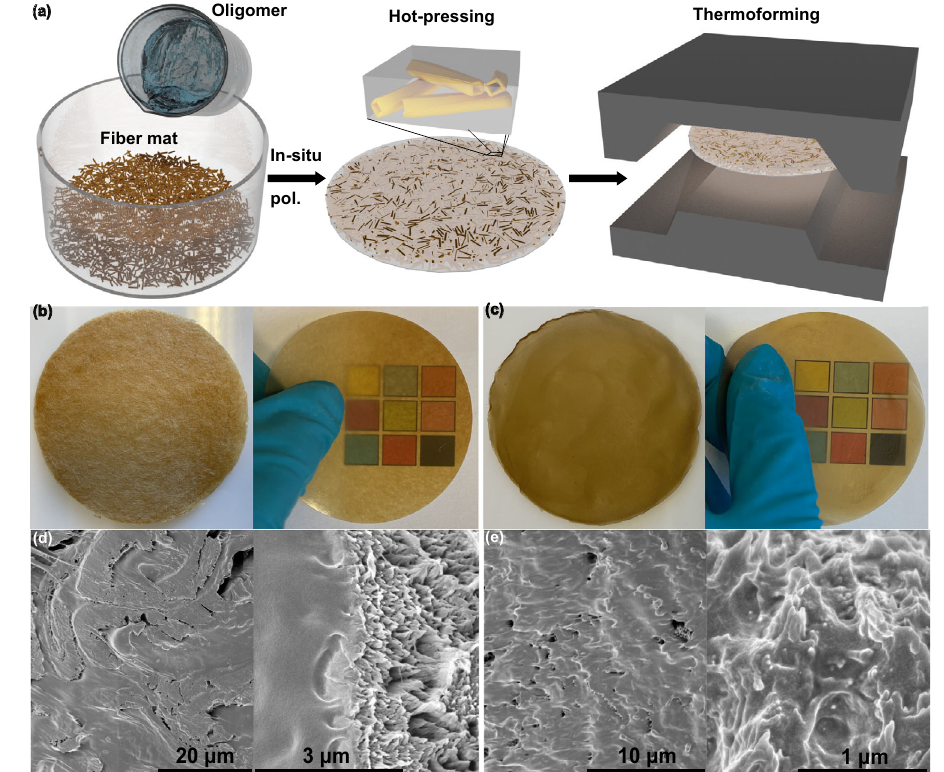
Fig.3|Schematicallydepictedpreparationproceduresofthebiocompositesas well as their macroscopic and microscopic structures. a Processing steps: impregnationof fi bermatwitholigomerliquid,in-situpolymerization,followedby hot-pressing. The wood fi ber (WF) polymer matrix biocomposite is then subjected to thermoforming for consolidation. In industrial process, thermoforming would also be a shaping step. b Photographs of 25% WF biocomposites from wood fi bers